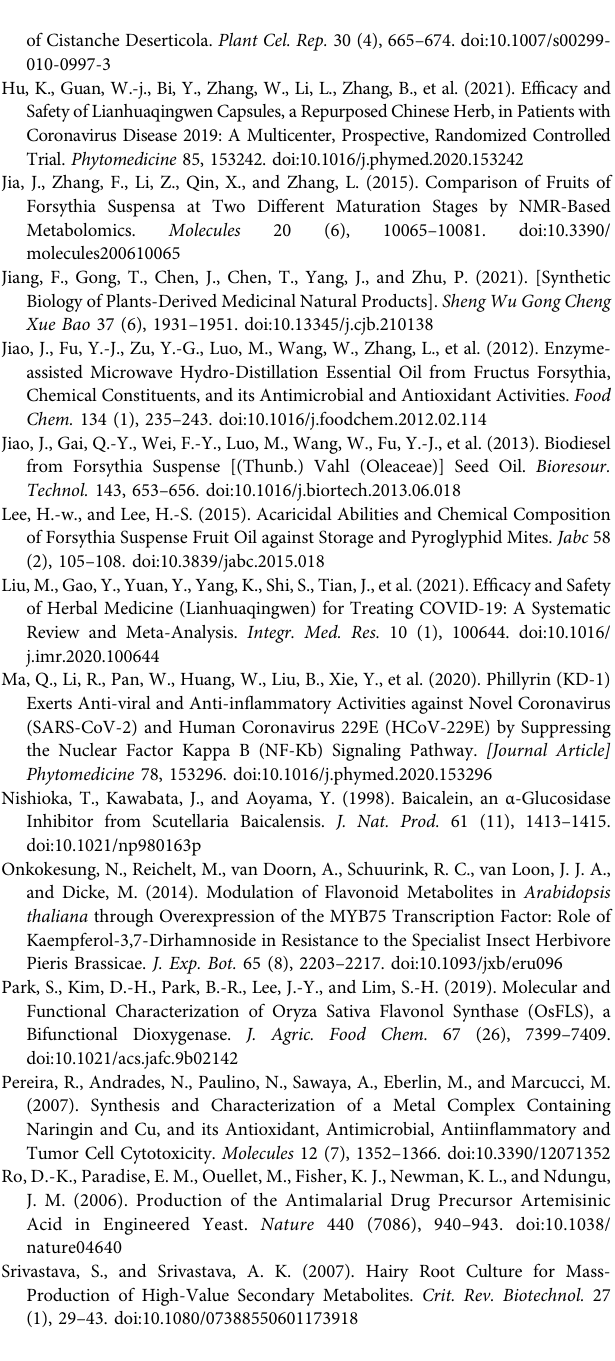
Supplementary Figure S2 | Characteristics of differential lipid molecules with OPLA-DA and